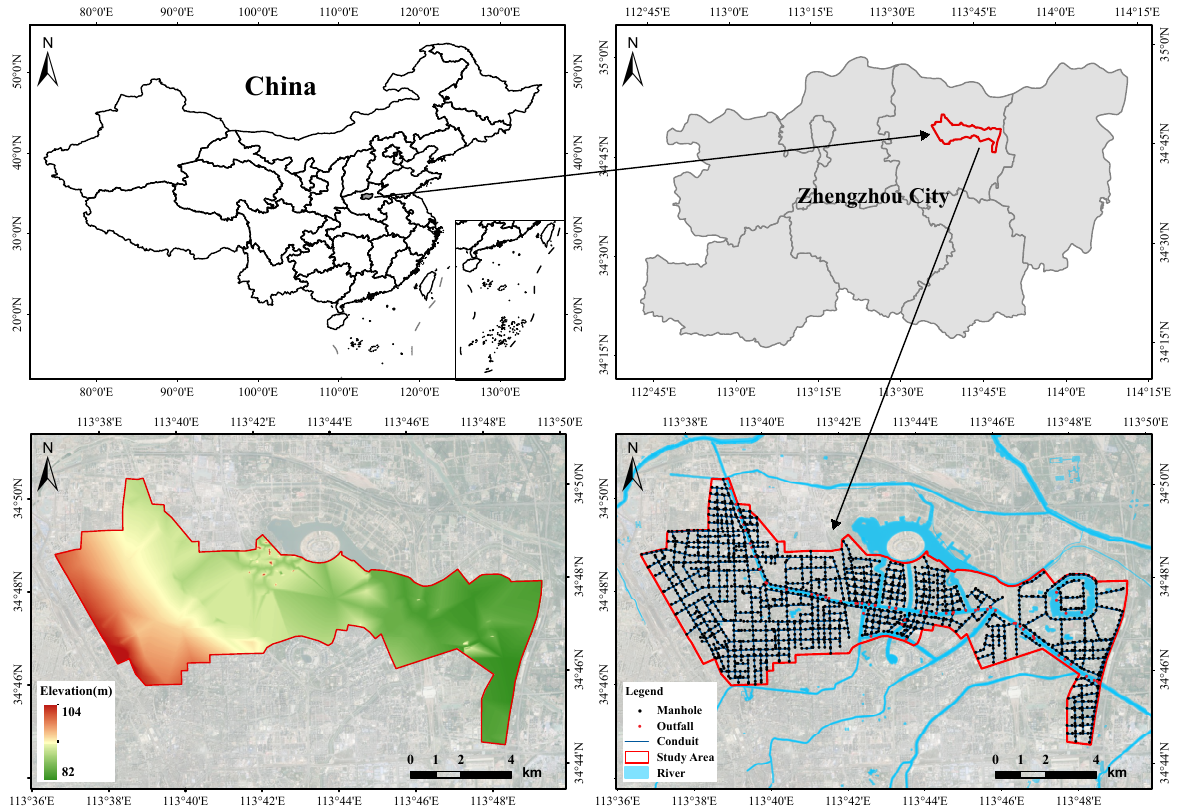
Figure 1. Location of the study area, stormwater network distribution, and elevation